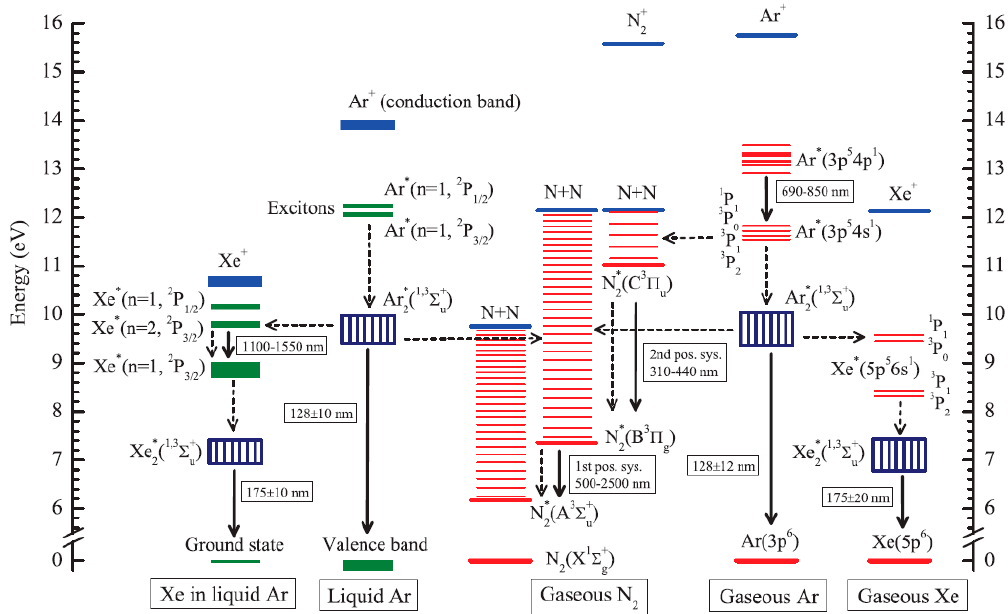
Figure 3. Energy levels of the lower excited and ionized states relevant to the ternary mixture of Ar doped with Xe and N 2 in the two-phase mode [7]. These are shown for gaseous Ar, gaseous N 2 , gaseous Xe, liquid Ar and Xe in liquid Ar. The solid arrows indicate the radiative transitions observed in experiments and relevant to the present review (i.e., when the excitation is induced by ionization or electroluminescence). The numbers next to each arrow show the photon emission band of the transition, defined by major emission lines or by full width of the emission continuum. The dashed arrows indicate the most probable non-radiative transitions induced by atomic collisions for Ar, Xe and N 2 species and their pair combinations in the gas and liquid phase.